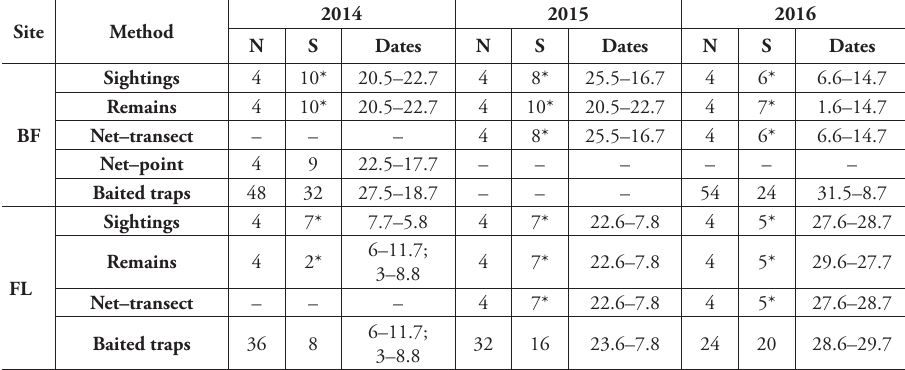
B B (Red Wine, Beer, w e a